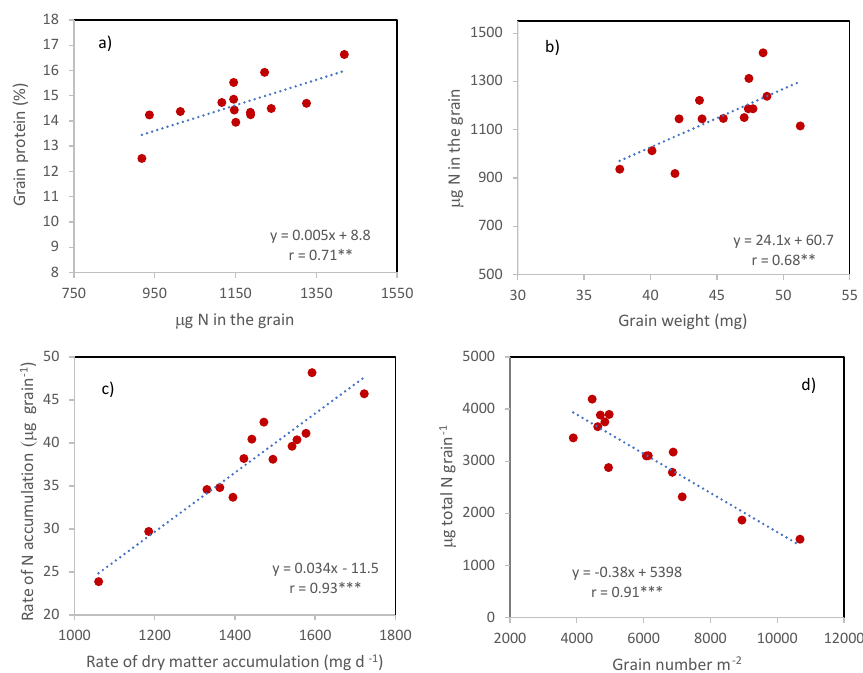
Figure 6. Relationships involving grain N percentage and content. ( a ) Relationship between grain protein percentage and grain protein content; ( b ) Relationship between grain protein content and grain weight; ( c ) Relationship between the rates of accumulation of N and dry matter in the grains; ( d ) Effect on the number of grains m -2 on grain N content. Points are cultivars means across years and N treatments. **, Pearson correlation coefficient significant at p ≤ 0.01; ***, Pearson correlation coefficient significant at p ≤ 0.001.